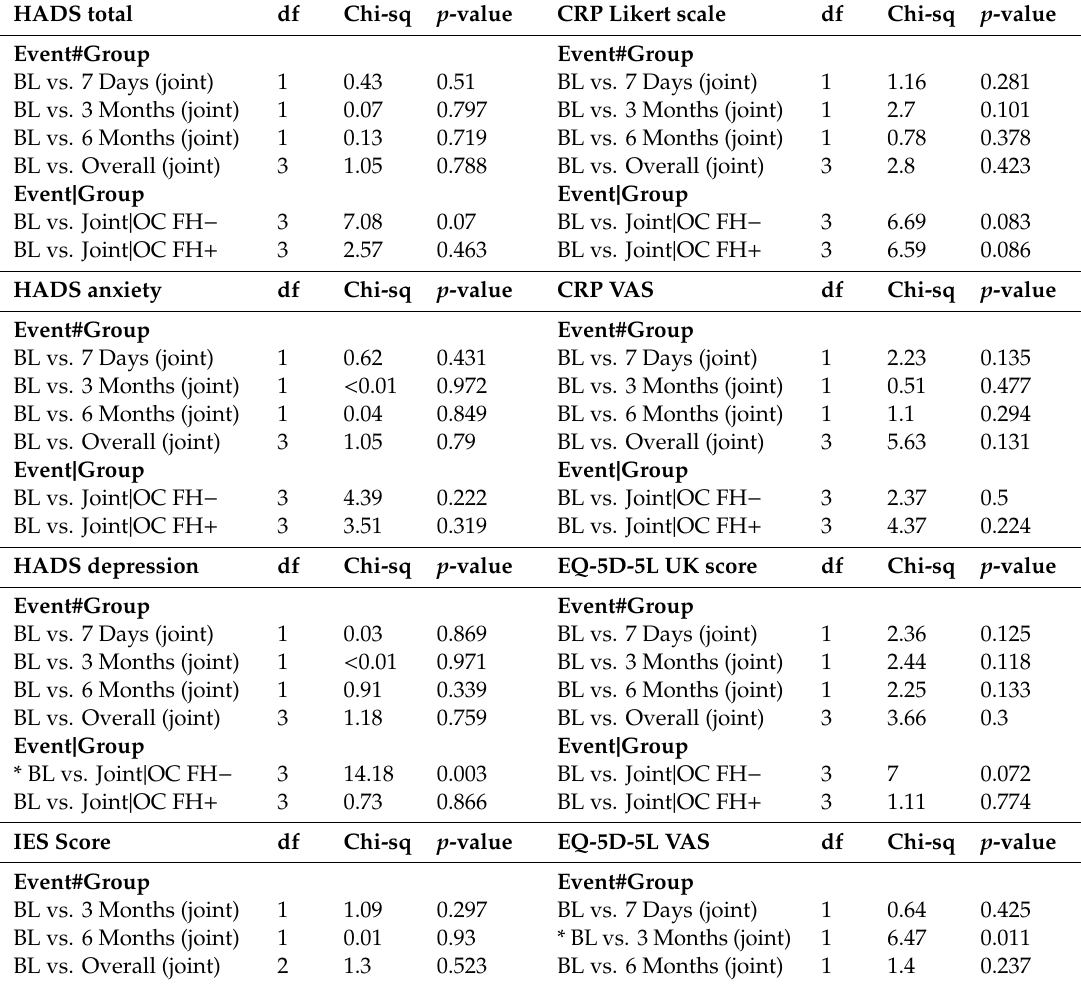
Table 7. Contrast tests for between-group and within-group analyses over